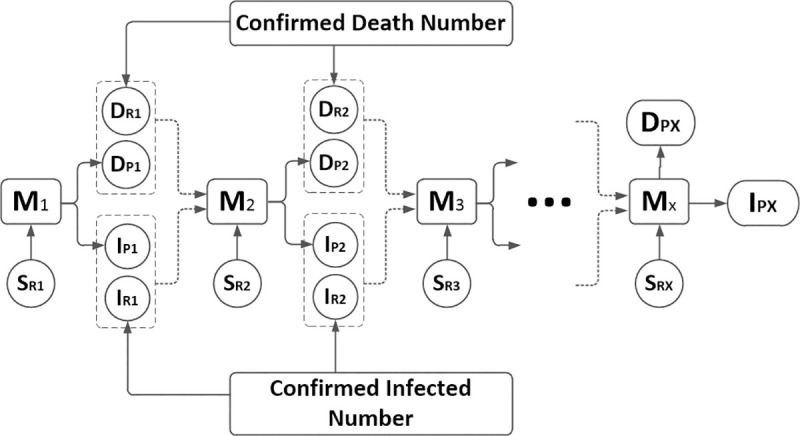
The LSTM method.